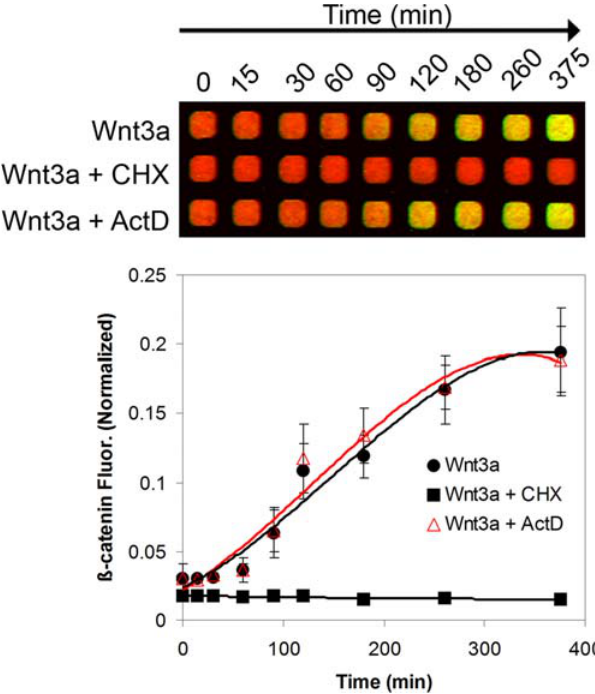
Figure 3. Dependence of Wnt3a-driven accumulation of cellular b -catenin on new protein but not RNA synthesis. L- cells were treated with Wnt3a (50 ng/ml) in the absence or presence of either cycloheximide (CHX, 100 m g/ml) or actinomycin D (ActD, 1 m M) and incubated for the indicated times (n=4).